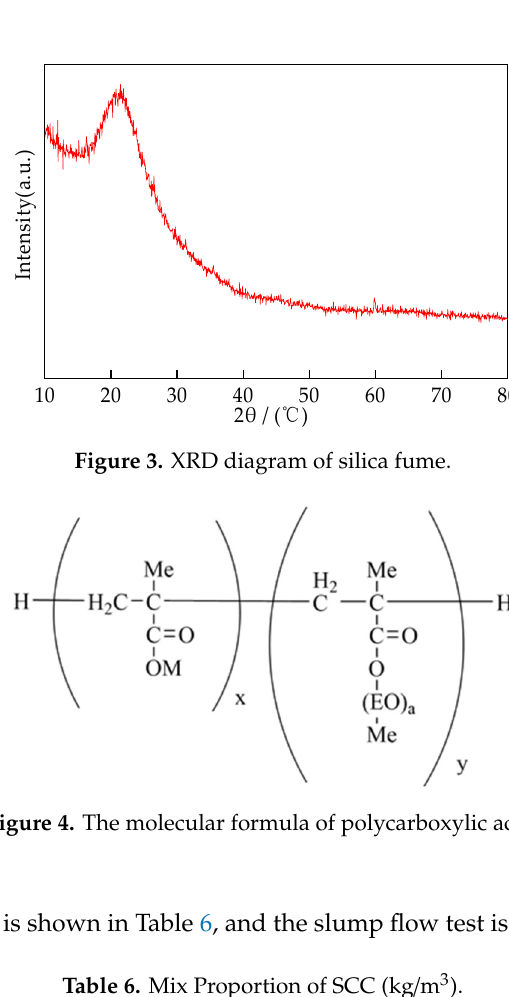
Table 6. Mix Proportion of SCC (kg / m 3 ).